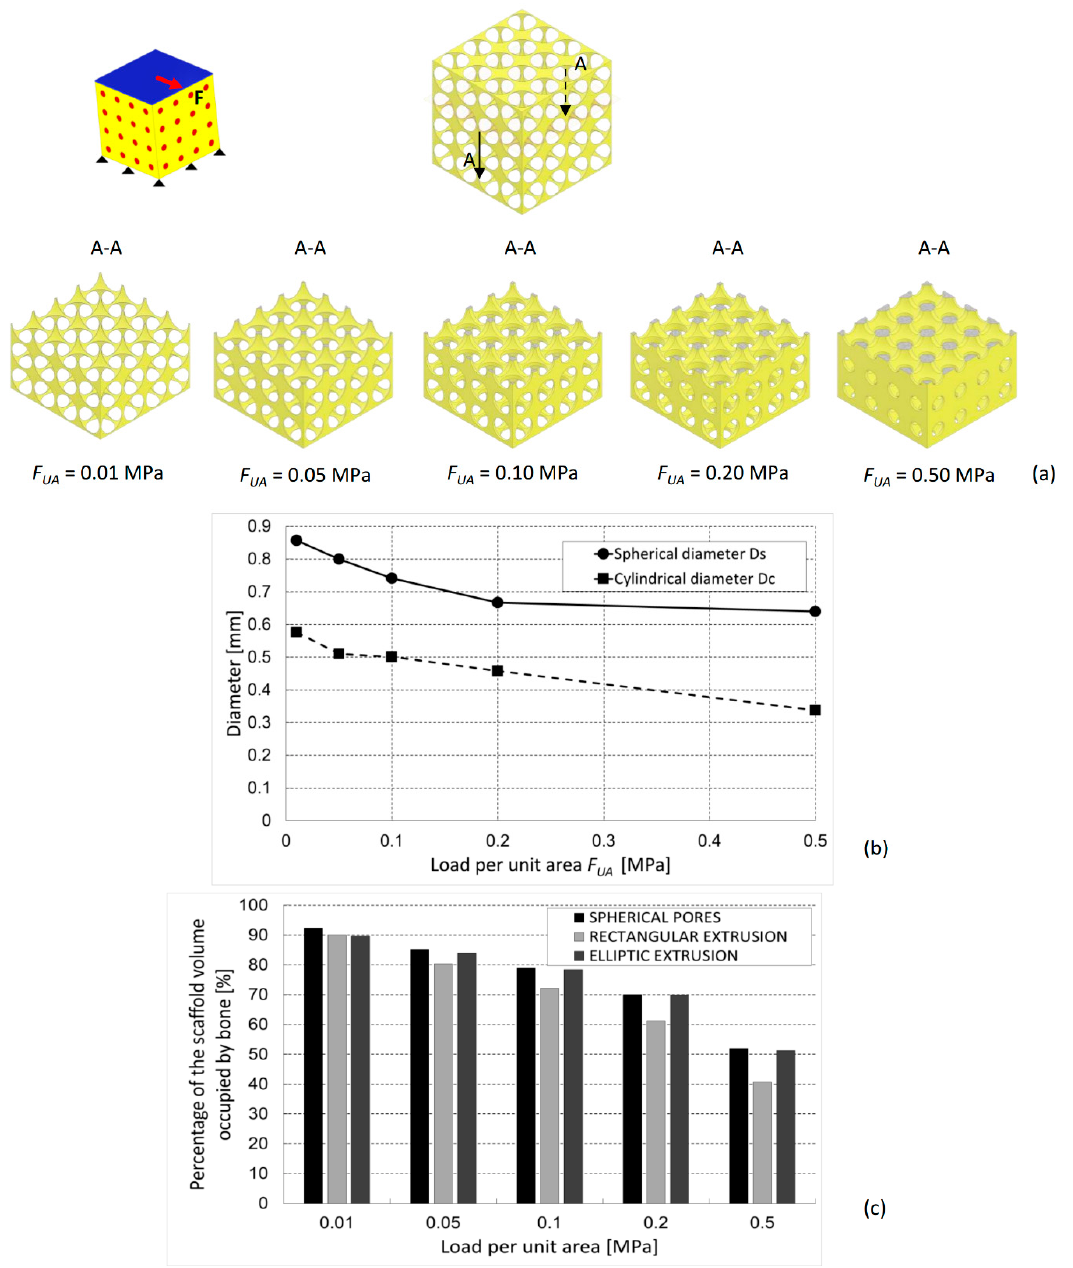
Figure 8. ( a ) Optimized scaffold geometries (section views A-A), ( b ) optimal values of D s and D c , and ( c ) percentage of the scaffold volume occupied by mature bone, predicted by the optimization algorithm for different values of the shear load. The percentages of bone are compared with those predicted for scaffolds with hexahedron unit cells including elliptic and rectangular extrusions [20].